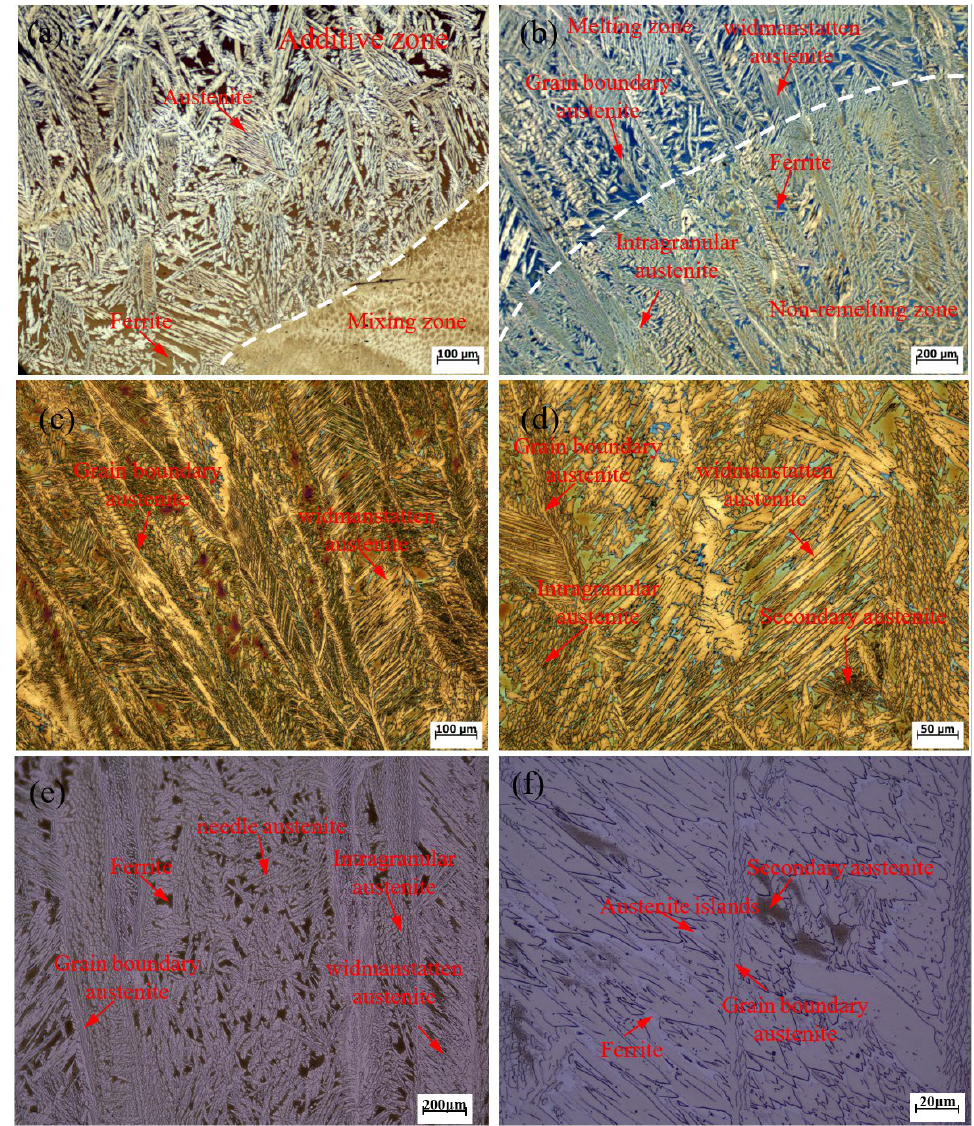
Figure 7. Microstructure of 2205 duplex stainless steel by WAAM. ( a , b ) Microstructure at the bottom along BD direction. ( c , d ) Microstructure in the middle along BD direction. ( e , f ) Upper microstructure along BD